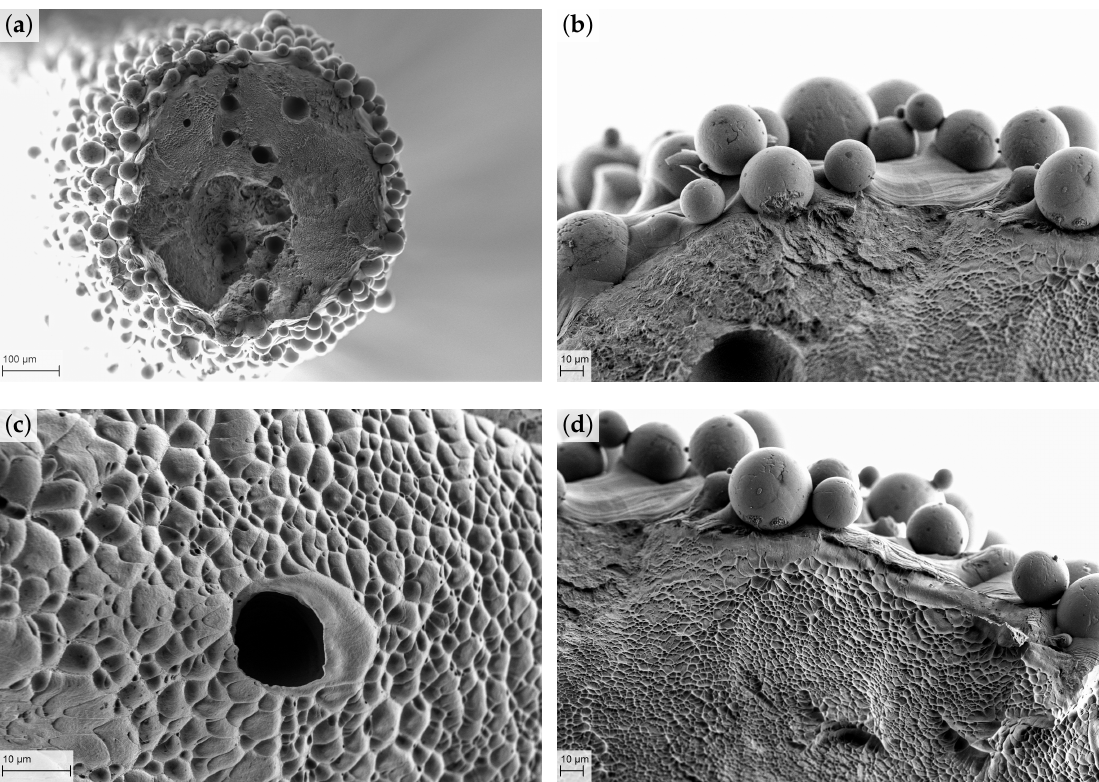
Figure 5. SEM fracture analysis of the solid sample L10D06. ( a ) Overview with pores at 250 × magnification. ( b ) Mixed fracture behavior at 1000 × . ( c ) Quasi-flat dimpled surface with pore at 3000 × . ( d ) Dimpled surface close to the outside surface at 1000 ×